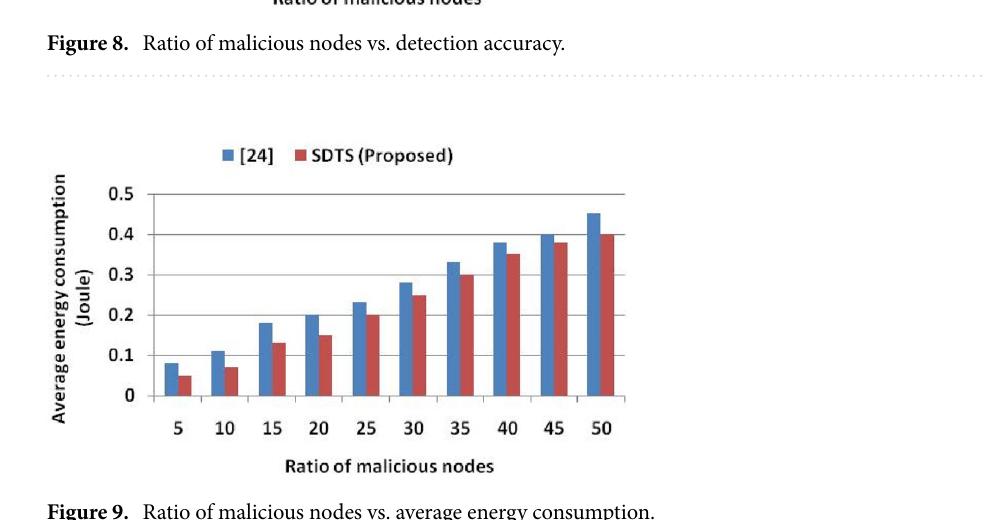
Figure 9. Ratio of malicious nodes vs. average energy consumption.